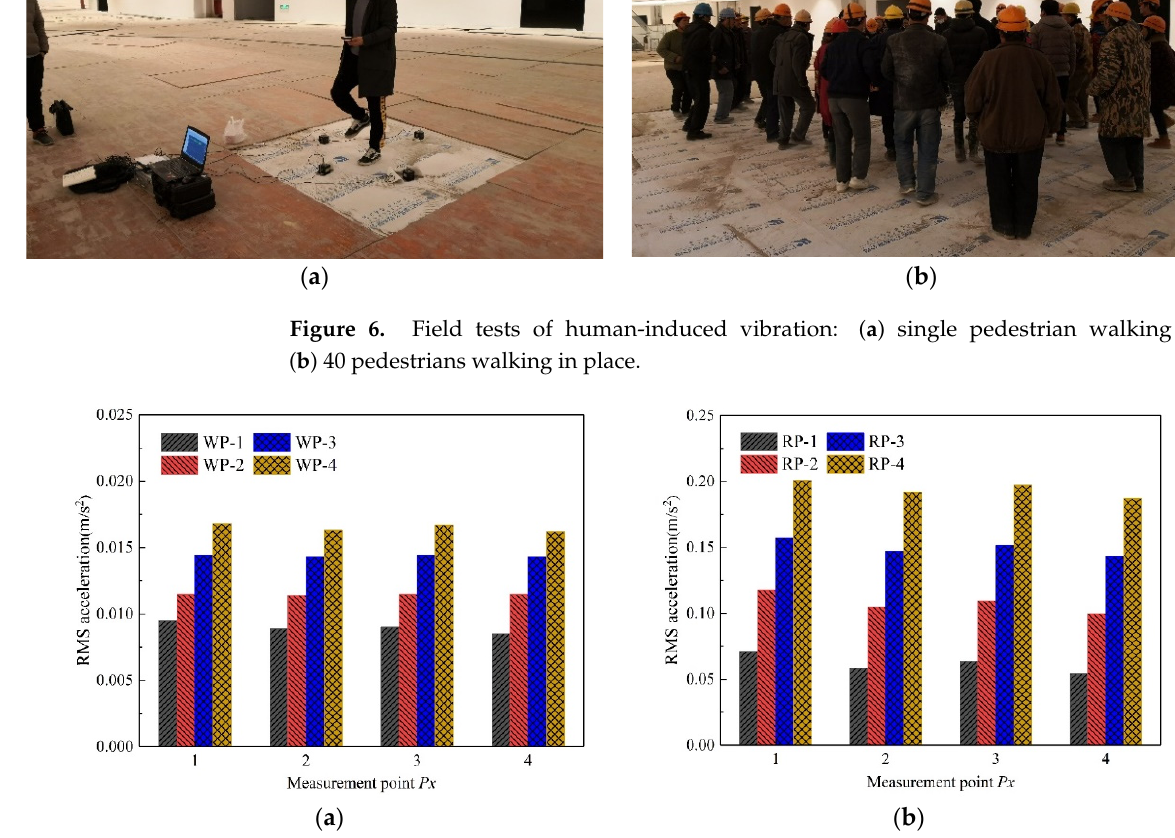
( b ) Figure 7. Comparisons of RMS accelerations at different measuring points under human-induced dynamic loads: ( a ) walking in place (1.77 Hz); ( b ) running in place (3.54 Hz).